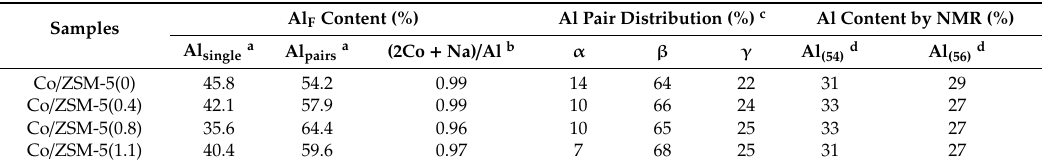
Table 4. Al distribution of Co-type ZSM-5 and